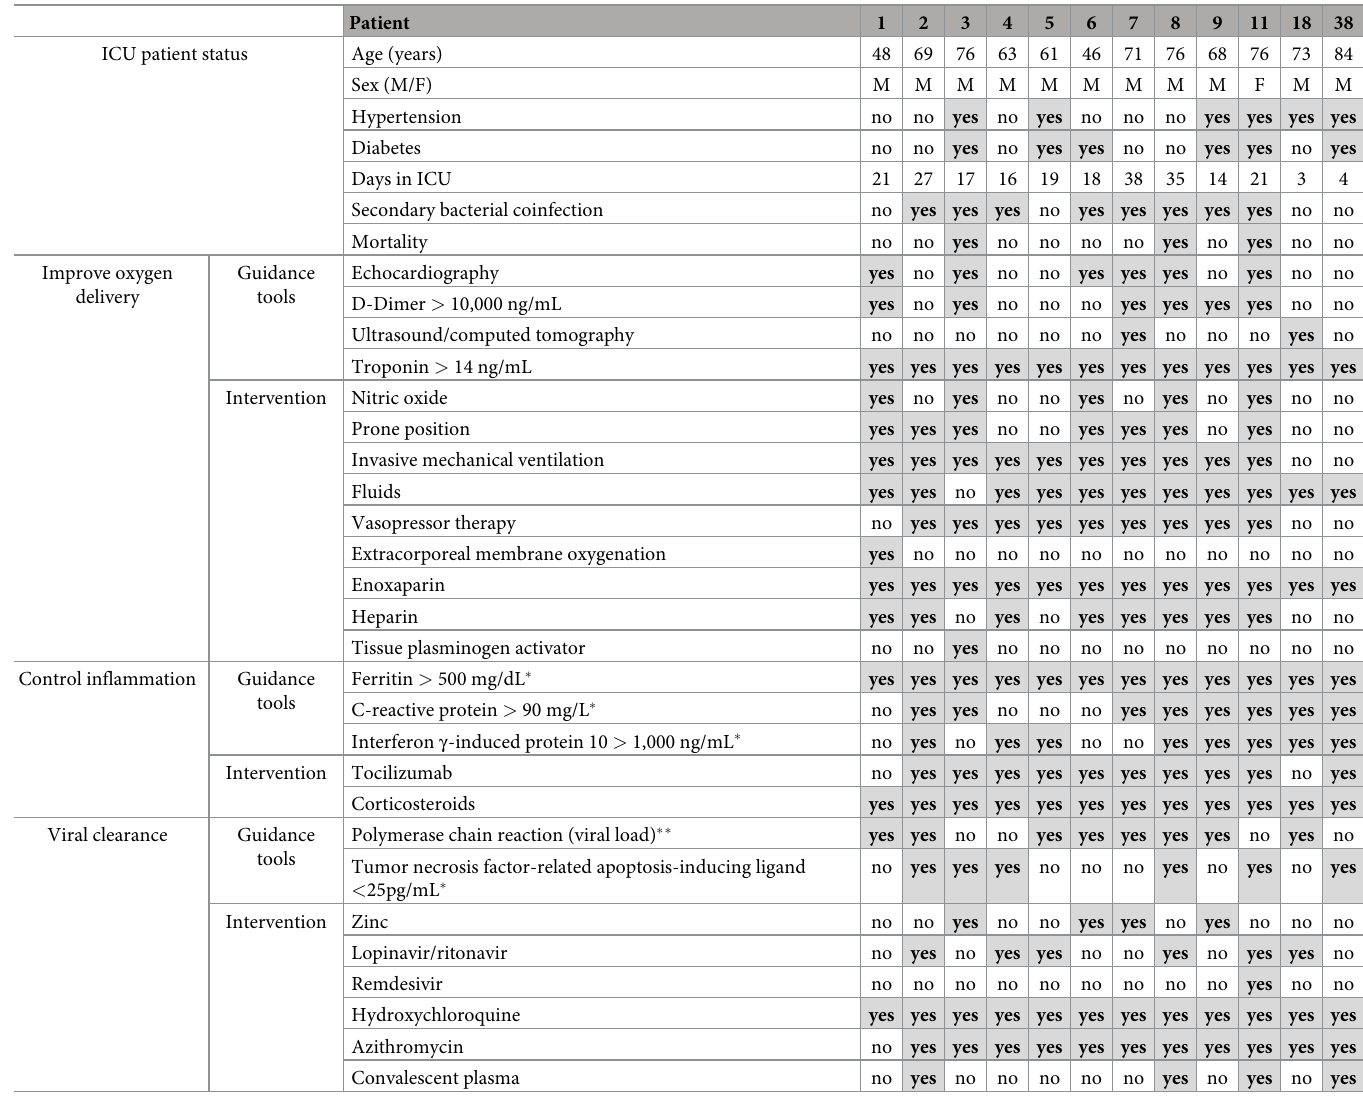
Table 2. Status of the 12 patients admitted to the intensive care unit